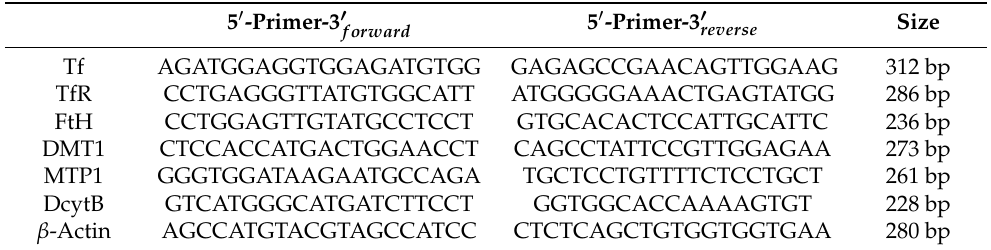
Table 2. Primer (Metabion, Planegg/Steinkirchen, Germany) used for qRT-PCR. β -actin was amplified as reference. Primer were designed with NCBI and